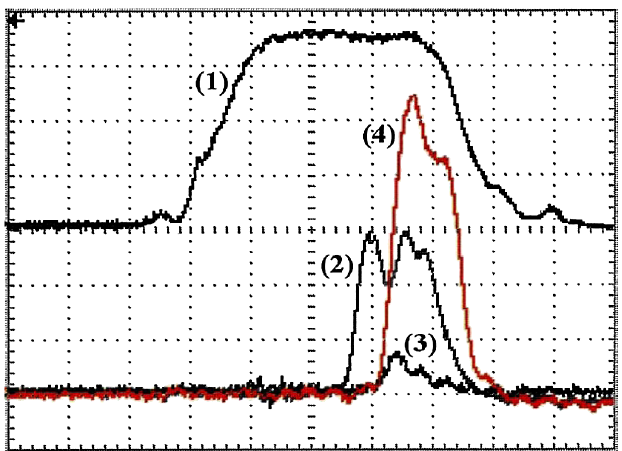
FIG. 5. FEM operating with the test resonator: oscilloscope traces of (1) beam current ( 60 A = div ), (2) rf pulse at the FEM output ( 5 MW = div ), (3) rf pulse reflected from the test resonator, and (4) rf pulse passed through the test resonator ( 0 : 5 MW = div ); time scale is 100 ns = div